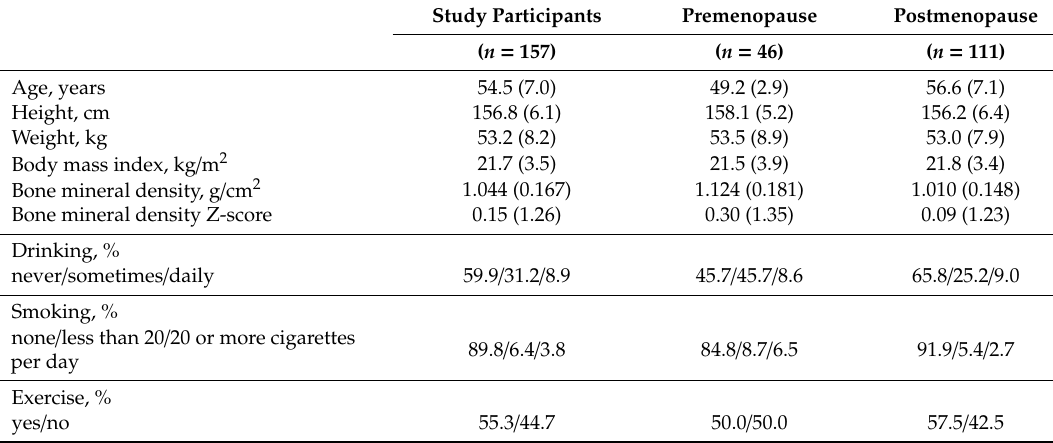
Table 2. Background characteristics of the